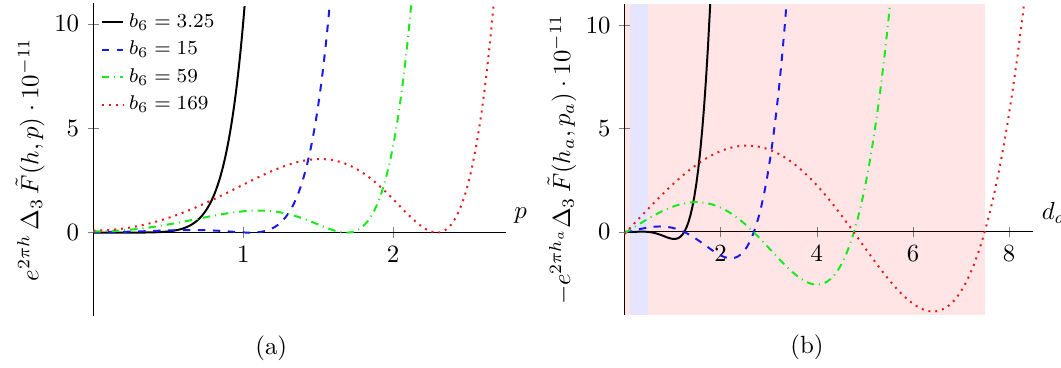
Figure 3. The contribution to the crossing equation (4.6) from (a) states with real-valued charges and (b) the state with imaginary charge p a 2 = d a . Larger values of b 6 extend D (3 ;i ) a further to (cid:0) the right. The blue shaded region denotes the contribution of D (2) a (see (cid:12)gure